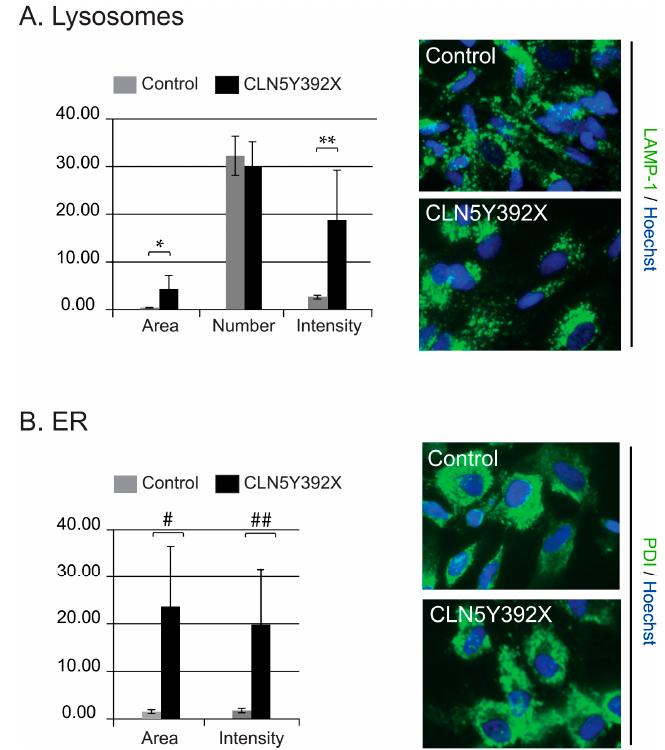
Figure 3. Analyses of lysosomes and the endoplasmic reticulum (ER) in iPSC-derived neural lineage cells. iPSC-derived neurospheres were further differentiated in adherent cultures. After ten days in an adherent culture, the cells were processed for nuclear (Hoechst 33258, blue), and lysosomal (LAMP-1, green) or ER (PDI, green) staining. Representative ScanR microscope images of lysosomal and the ER compartments ( A and B , respectively) are shown. Quantitative image analyses show the average values (arbitrary units) of total area, the number and intensity of vesicular LAMP-1-positive compartments in control and CLN5Y392X neural lineage cells ( A ); the size of the ER was determined as the area of PDI-stained structures ( B ). All columns represent the average values of 6–8 replicates each normalised to the number of cells analysed in the replicate (average of 1231 and 1183 cells per replicate for LAMP-1 and ER analysis, respectively). The error bars represent standard deviations (stdevp). p -values, 0.0243 (*), 0.0183 (**), 0.0119 (#) and 0.0140 (##) (two-tailed Student’s t test).